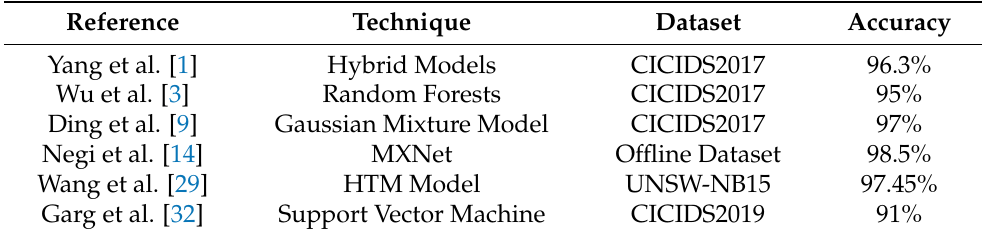
Table 1. Comparative analysis of previous